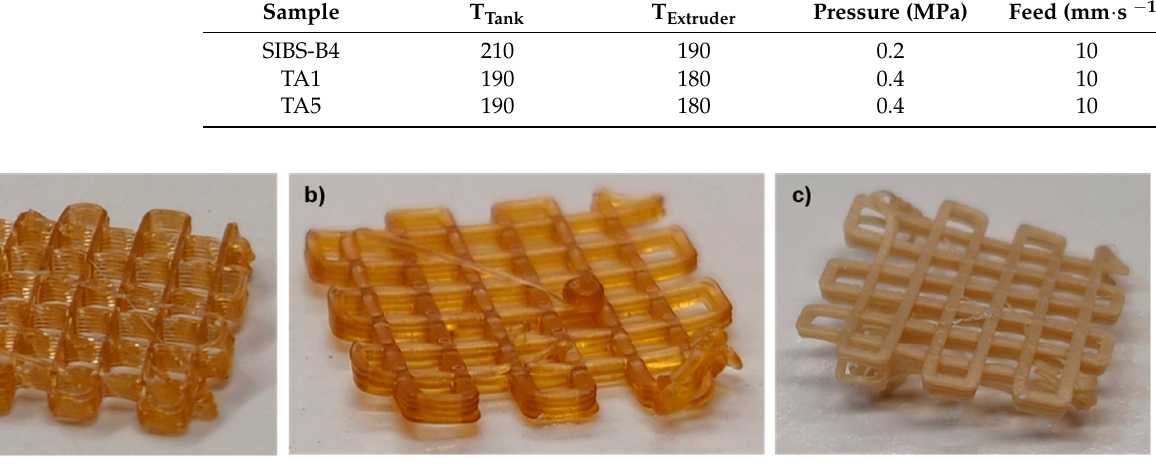
Figure 4. Photos of 3D-printed grids of 10 mm × 10 mm. ( a ) SIBS-B15; ( b ) SIBS-B15 mixed with TA (5 wt %); ( c ) SIBS-B15 mixed with TA (5 wt %) after the drug release. Height of the printed specimen is approx. 5 mm.